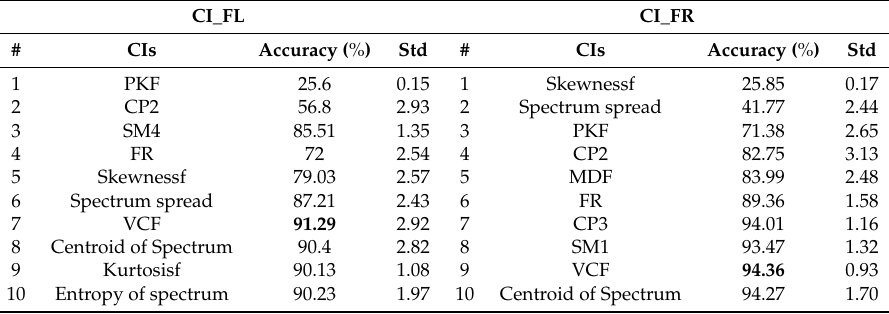
Table 5. Top 10 features and accuracies average over frequency domain.